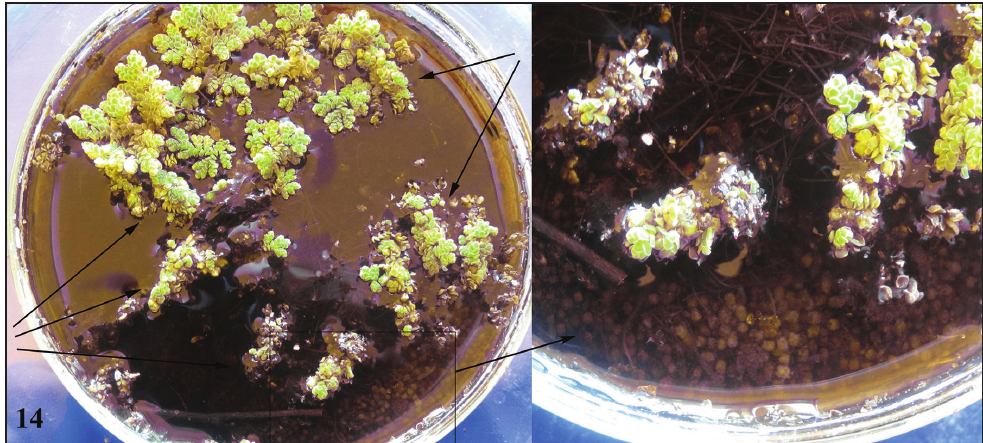
Figure 14. Evidence of Cataclysta lemnata activity. Larval shelters on surface; magnified: frass and stems at bottom of Petri silver dot; fringe white with dark line at base (Fig. 2). Female with head and thorax brown. Fore- wing fuscous and fringe with obscure markings as in males; hindwing as in male, with an irregular fuscous median fascia and a white lined fringe (Fig. 1).